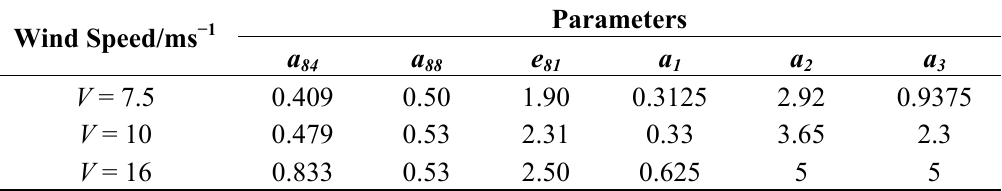
Table 2. Parameters of linearized model in different working points.